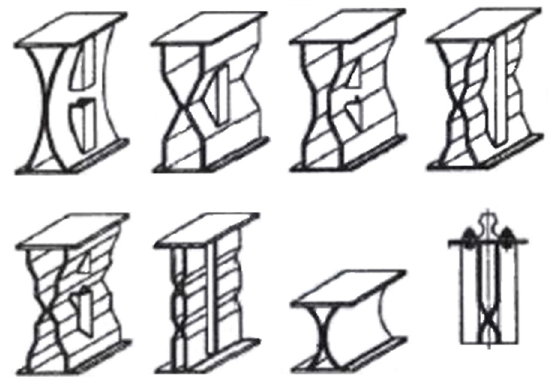
Figure 1. Plate girders with folds parallel to the longitudinal axis of the plate girder [1].